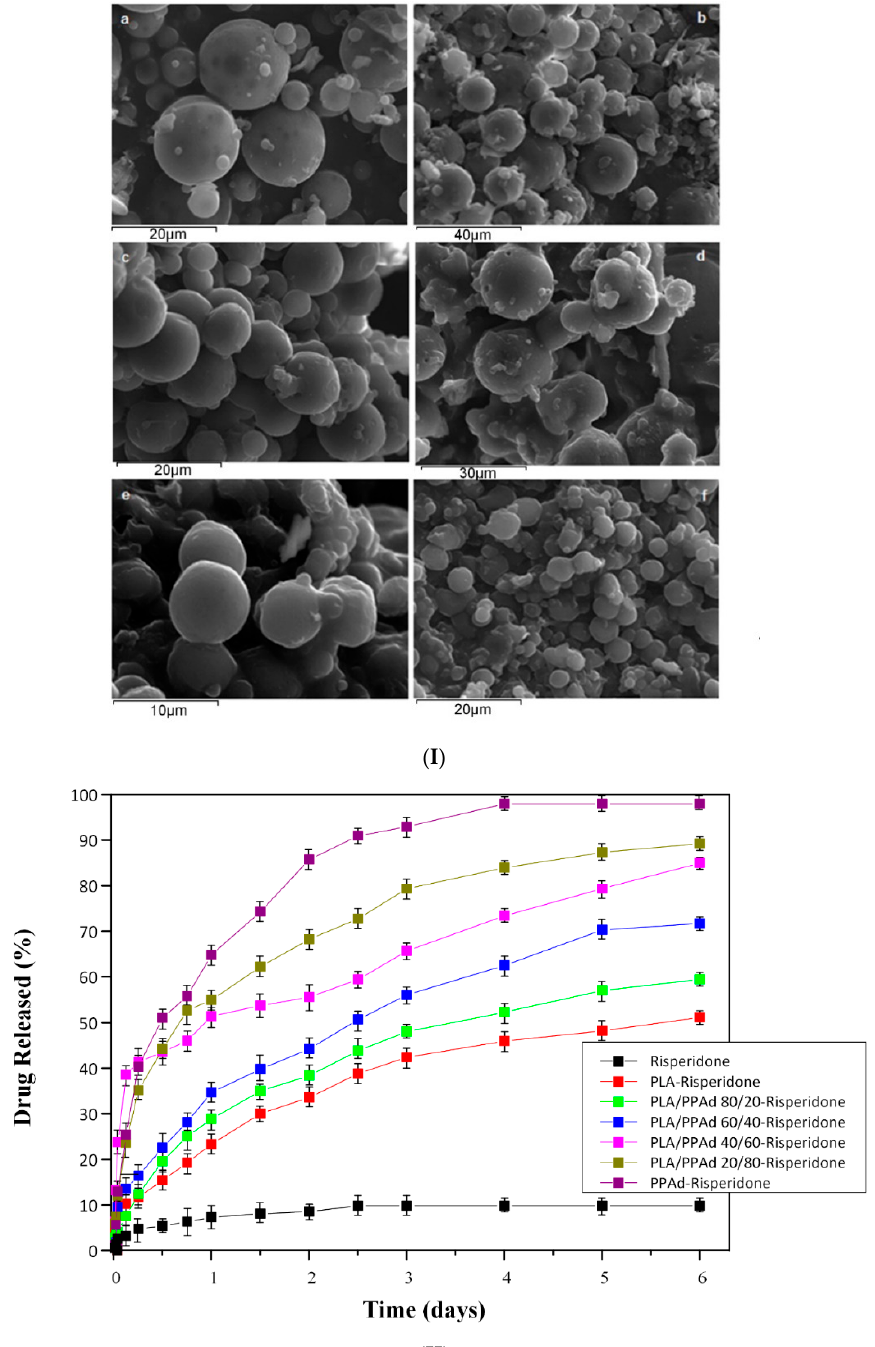
Figure 13. ( I ) SEM micrographs of risperidone microspheres prepared by neat PLA (a), PLA/PPAd 80/20 w/w (b), PLA/PPAd 60/40 w/w (c), PLA/PPAd 40/60 w/w (d), PLA/PPAd 20/80 w/w (e) and neat PPAd (f). ( II ) In vitro release profiles of risperidone drug loaded microspheres prepared using PLA, PPAd and PLA/PPAd blends